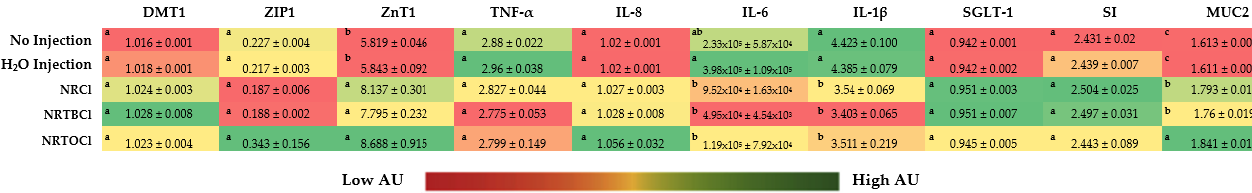
Figure 9. Effects of the intraamniotic administration of experimental solutions on duodenal gene expression. Values are the means ± SEM, n = 10. a – c Per gene, treatments groups not indicated by the same letter within the same column are significantly different ( p < 0.05). DMT1, Divalent metal trans-